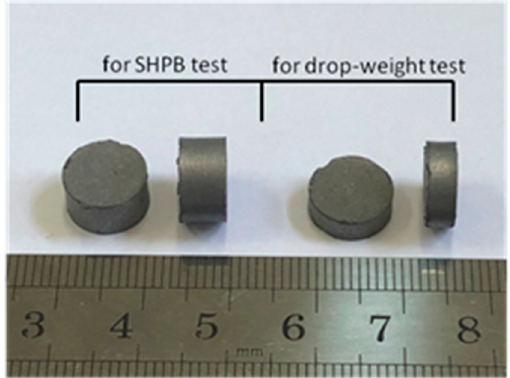
Figure 2. The cylindrical samples after sintered.